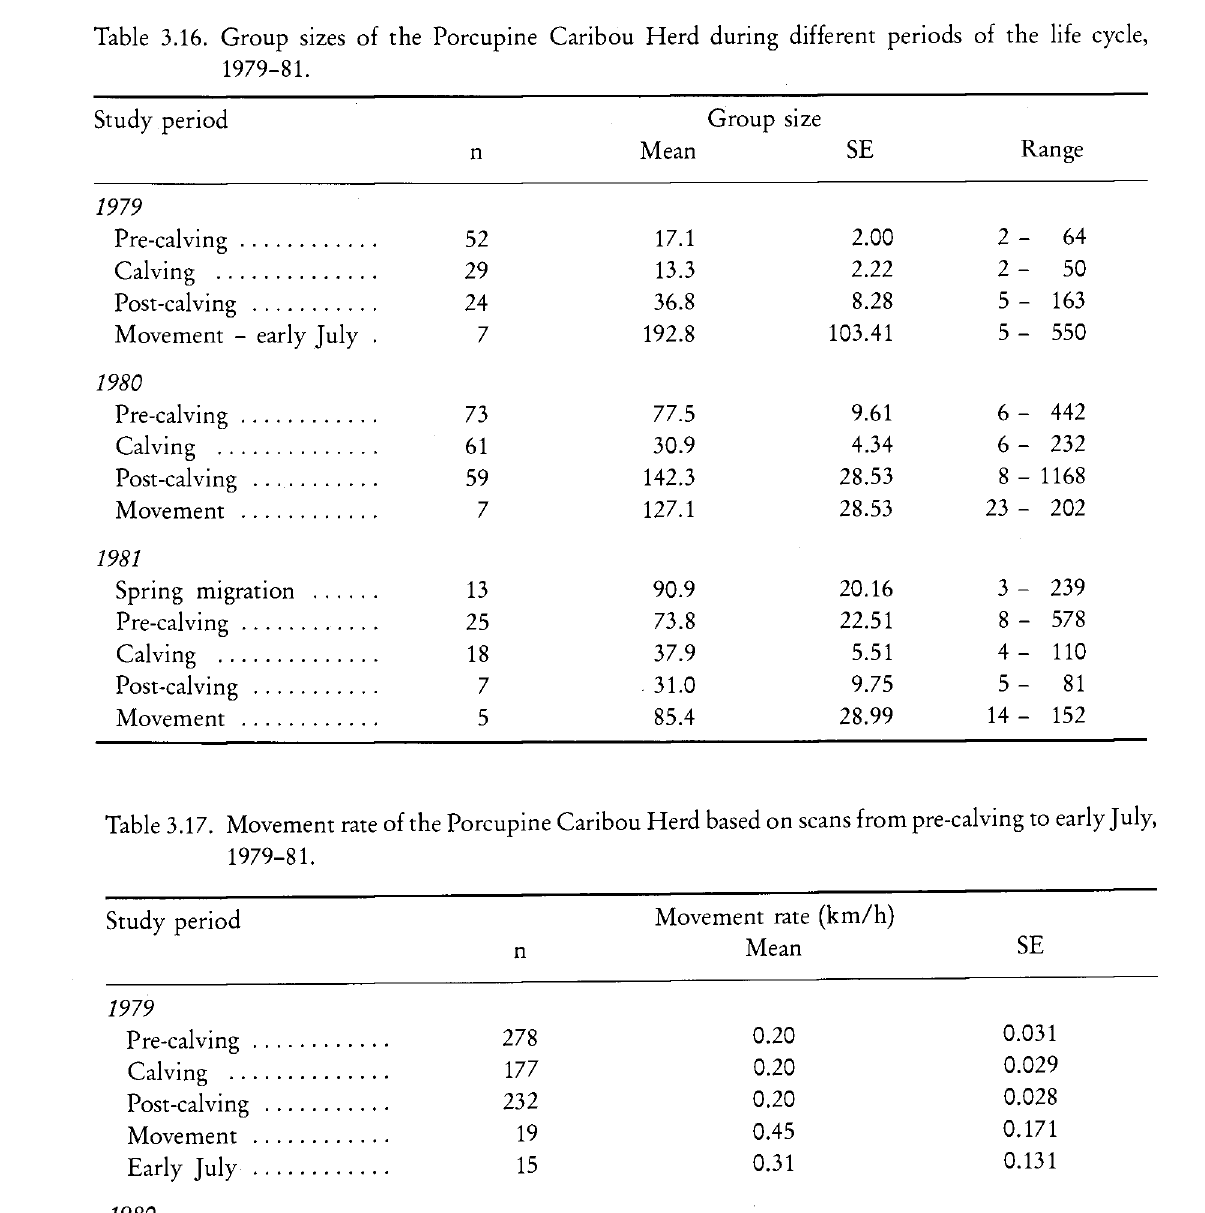
Table 3.16. Group sizes of the Porcupine Caribou Herd during different periods of the life cycle, 1979-81. Study period